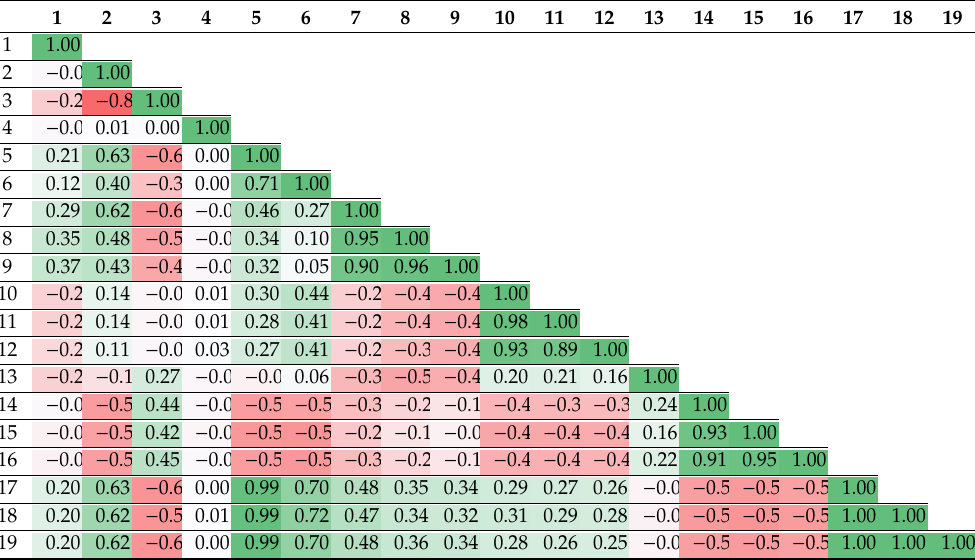
Table 5. Correlation matrix of power quality (PQ) and weather parameters for 10 min aggregated data.